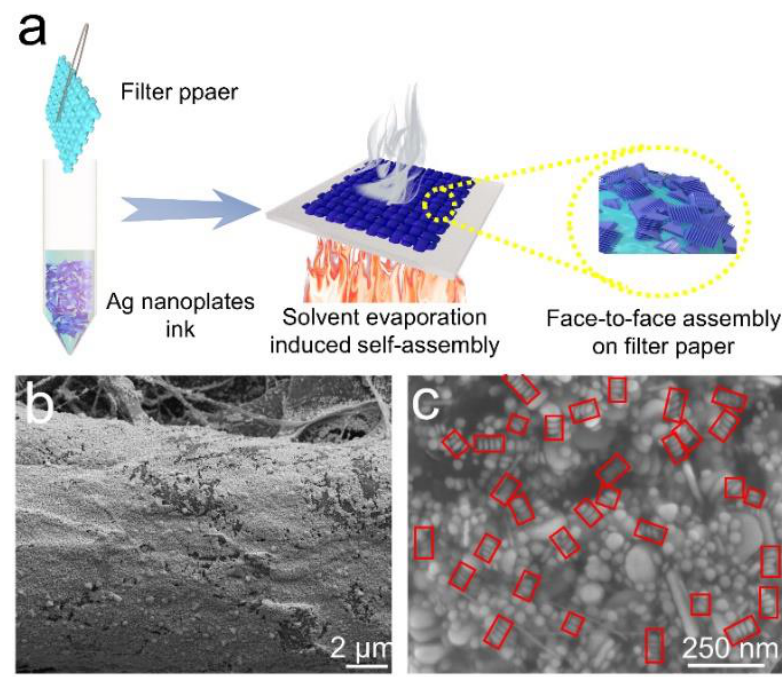
Figure 2. Characterization of paper-based SERS substrates. ( a ) Schematic diagram of fabrication of paper-based SERS substrates. ( b , c ) SEM images of Ag NPs coated filter paper. Red boxes in ( c ) indicate the face-to-face stacked silver triangle nanoplates.